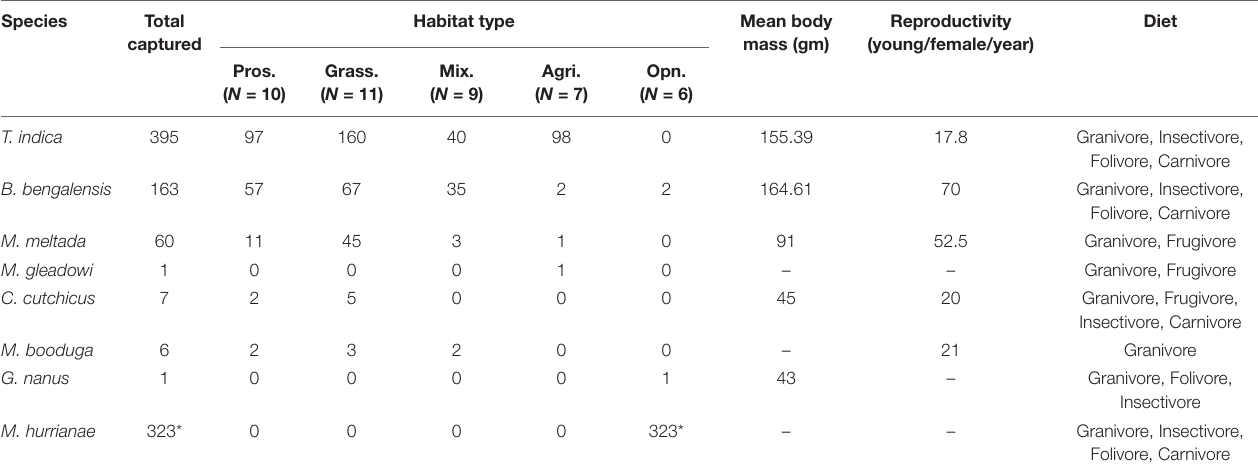
TABLE 1 | Summary of the total number of unique individuals of each species captured in the different habitat types. Also shown are the associated mean body mass, level of reproductivity, and diet type for each species (from Prakash and Singh, 2005). Species